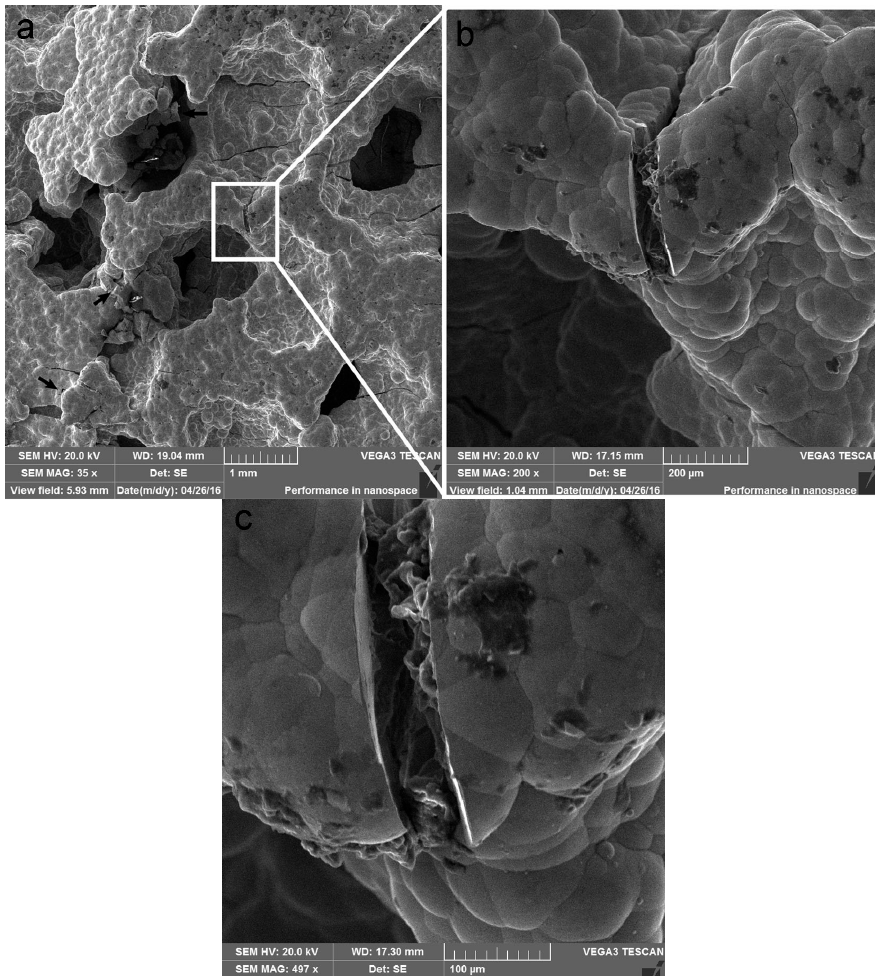
Figure 12. The failure of as-received foam at 200 °C.